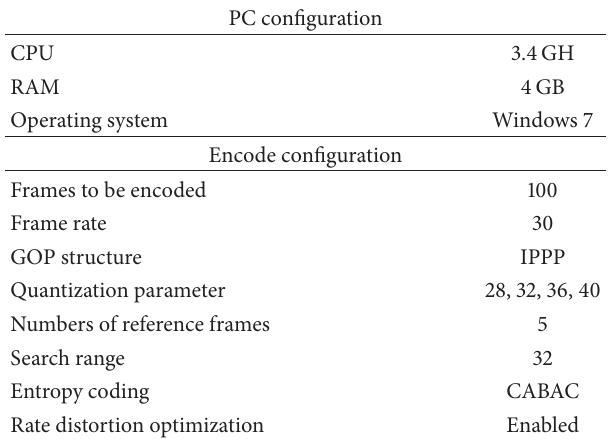
Table 2: Experimental